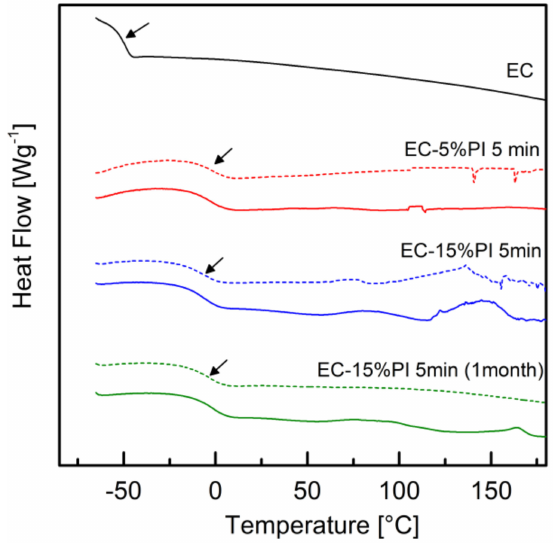
Figure 11. DSC thermograms of EC, of cured (5 min at 100 mW cm − 2 ) EC-5%PI and of cured EC-15%PI (5 min at 100 mW cm − 2 ) tested immediately and after one month from irradiation; full lines indicate the first heating scan, and dashed lines the second heating scan. The arrows indicate the glass transition